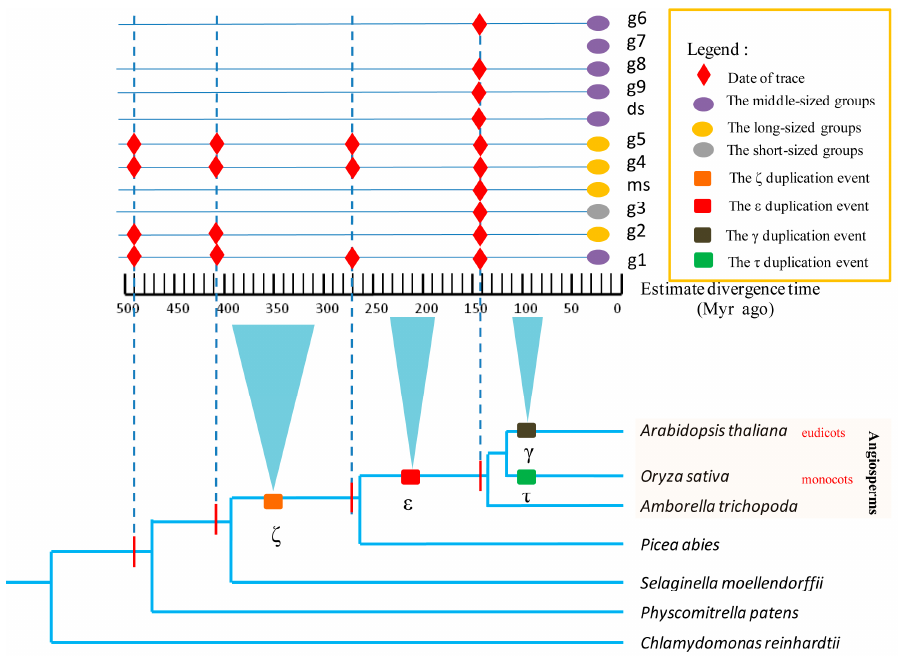
Figure 2. The evolutionary profiles of flowering plant SBP genes compared with other taxa of plants. The timeline is in the middle, and the approximate time range of each whole genome duplication event is shown in an inverted triangle linked to the timeline. The dotted line refers to the furthest traceable time of each species. The red rhombus on the cross of a dotted line and a solid line represents homologous genes of a group that were found in a species.